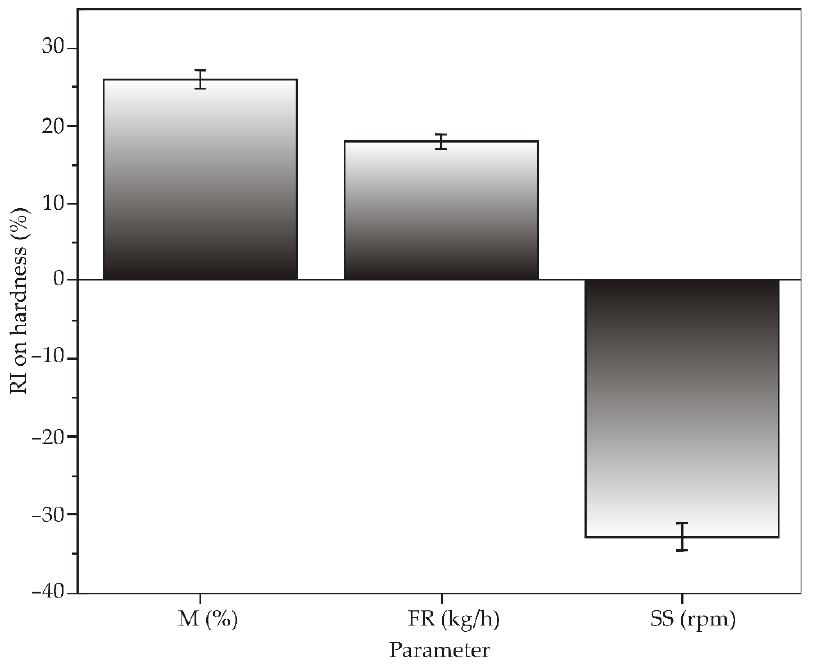
Figure 2. The relative importance of extrusion parameters on hardness using Yoon’s interpretation method. Table 3. Experimental color values of snack according to the adopted CCRD experimental